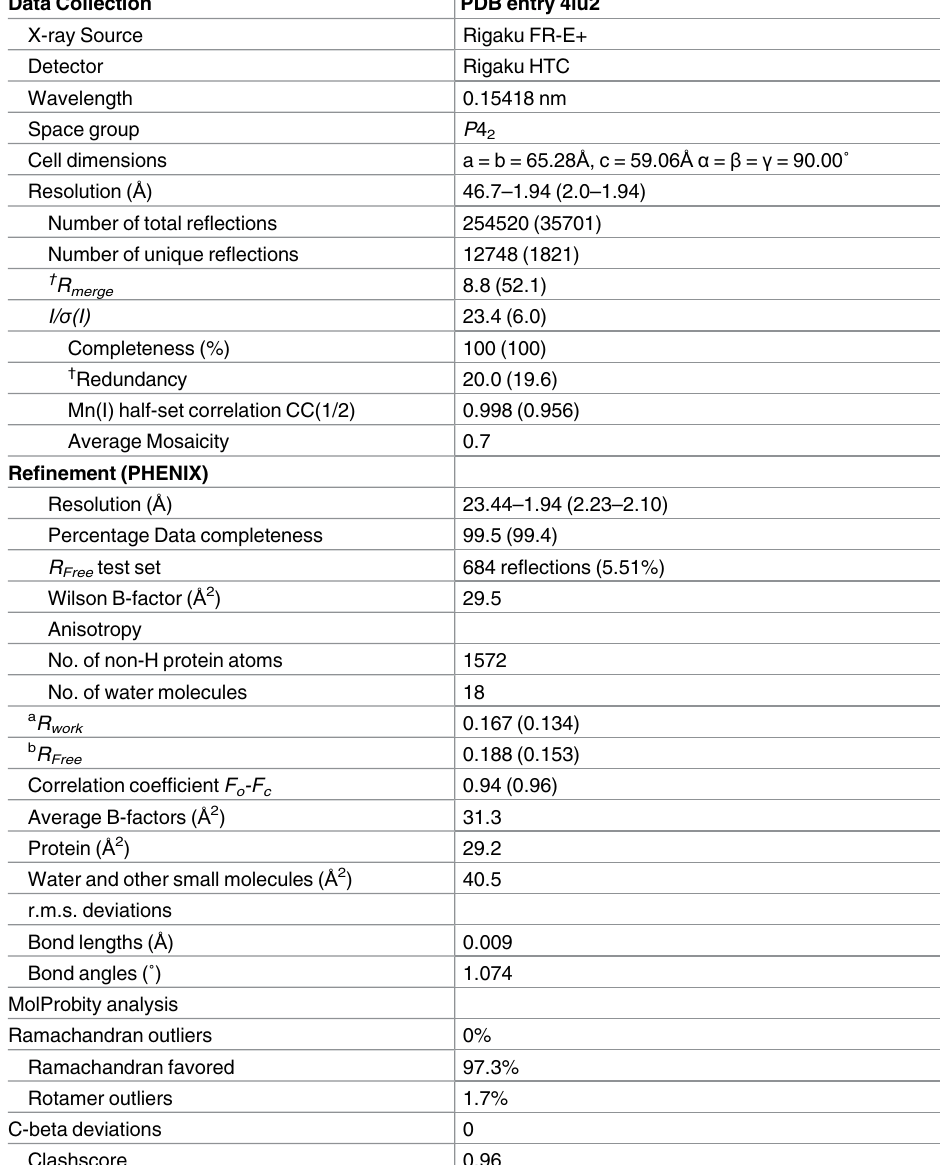
Table 1. Statistics for data collection and model